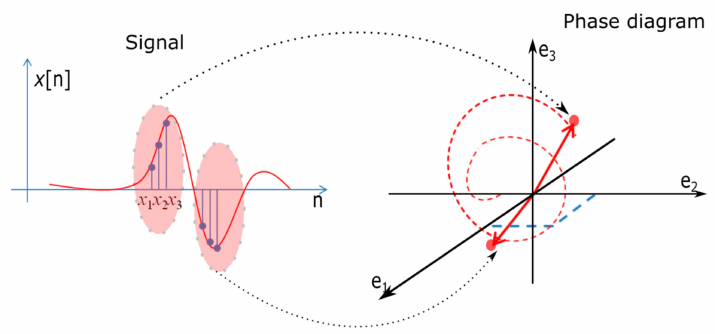
Figure 2. Illustration of the phase space trajectory